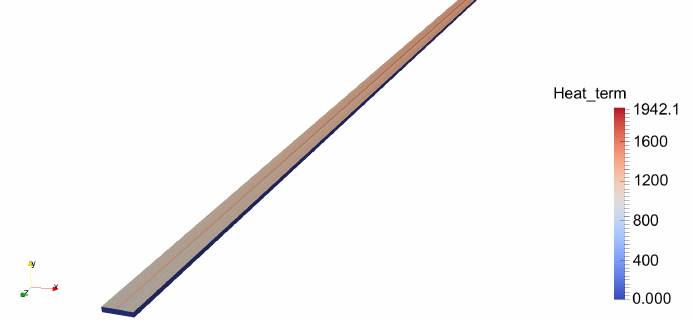
Figure 14. Heat- generation source (in W/m 3 ) for ω 1 = 2.45 GHz and the incident electric field polarized in the direction of the